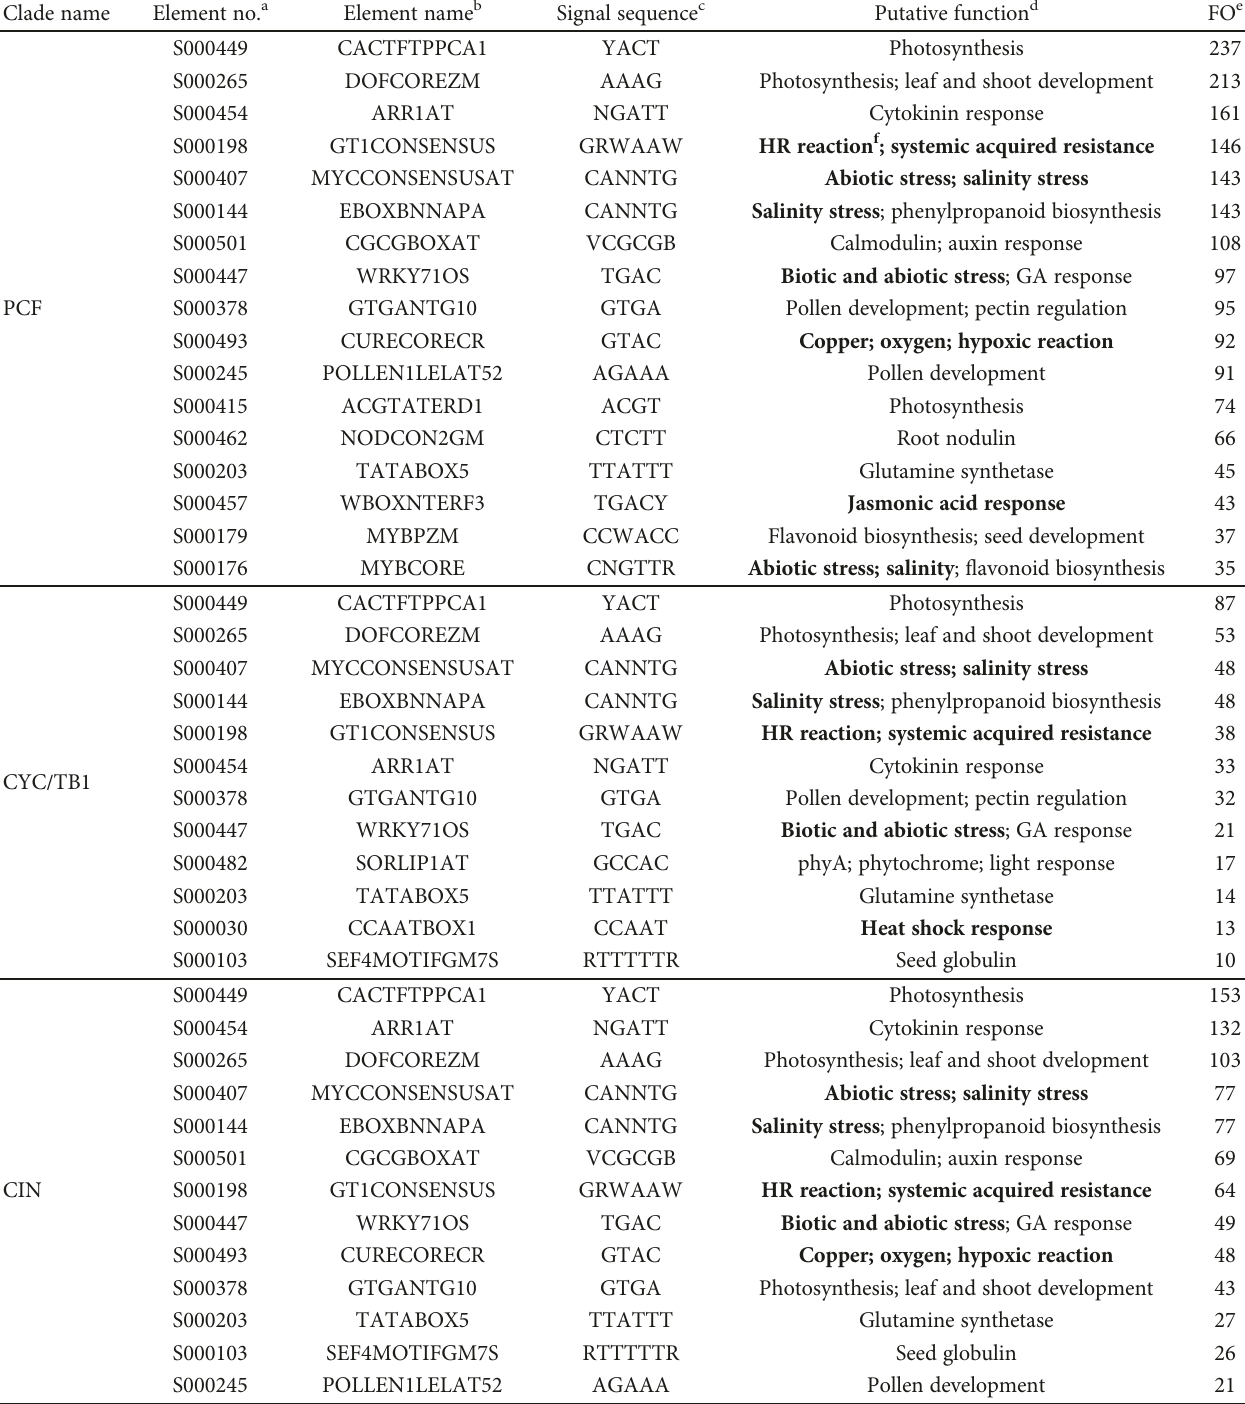
Table 3: Putative cis -acting DNA elements in the promoter of PvTCP